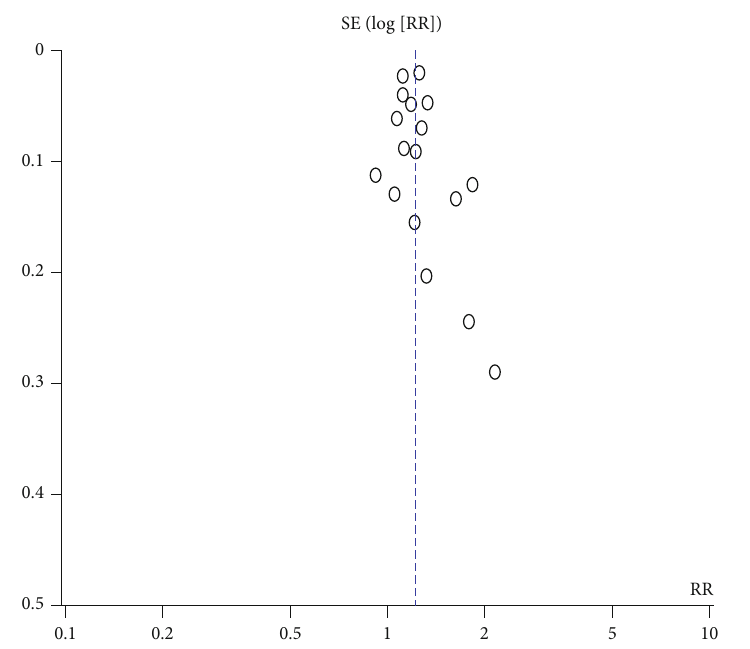
Figure 11: Funnel plots of publication bias for the association between SSD and